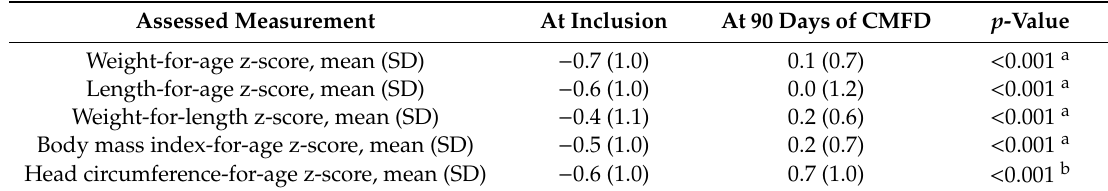
Table 3. Growth indices in the 29 patients who completed the follow-up. Assessed Measurement At Inclusion At 90 Days of CMFD p -Value Weight-for-age z-score, mean (SD) − 0.7 (1.0) 0.1 (0.7) < 0.001 a Length-for-age z-score, mean (SD) − 0.6 (1.0) 0.0 (1.2) < 0.001 a Weight-for-length z-score, mean (SD) − 0.4 (1.1) 0.2 (0.6) < 0.001 a Body mass index-for-age z-score, mean (SD) − 0.5 (1.0) 0.2 (0.7) < 0.001